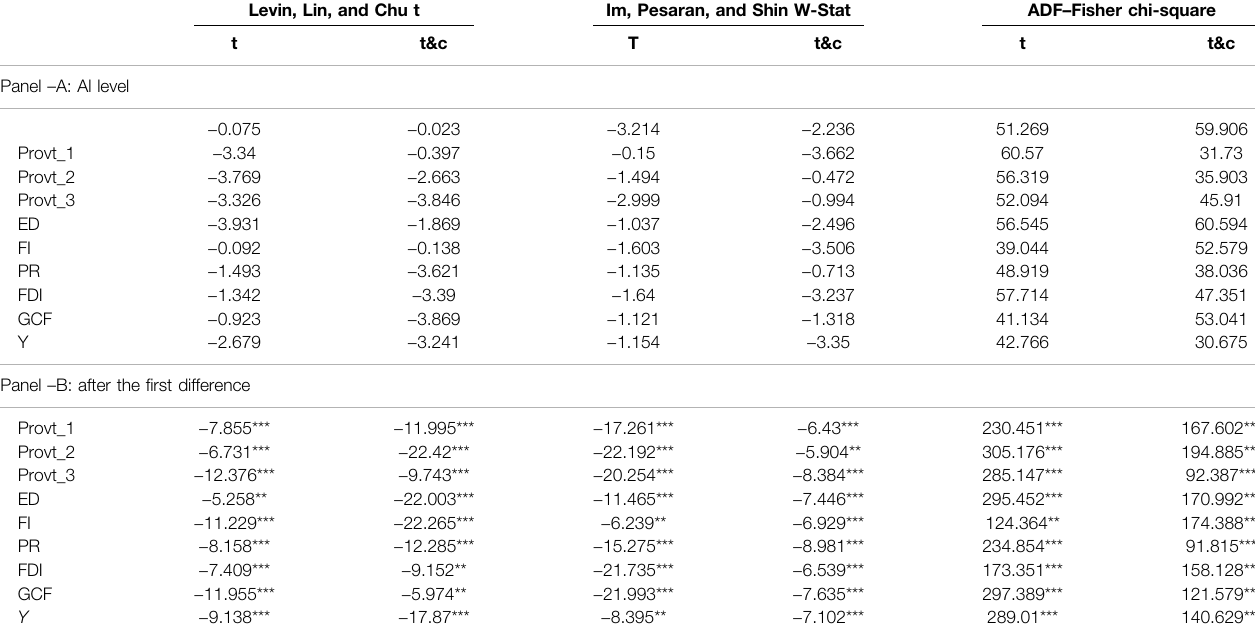
TABLE 6 | Results of the fi rst-generation panel unit root test.